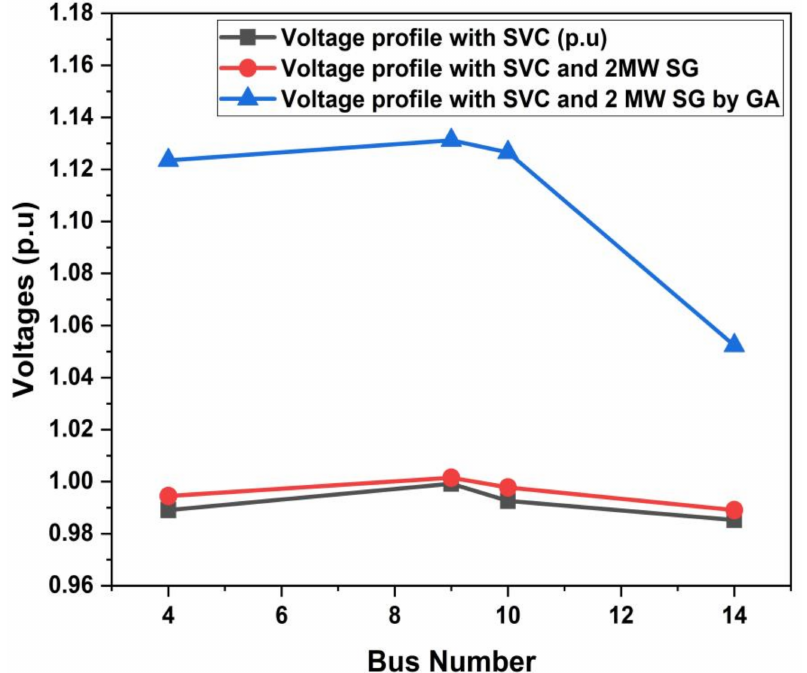
Figure 7. Voltage profile on IEEE 14-bus system with 2 MW solar